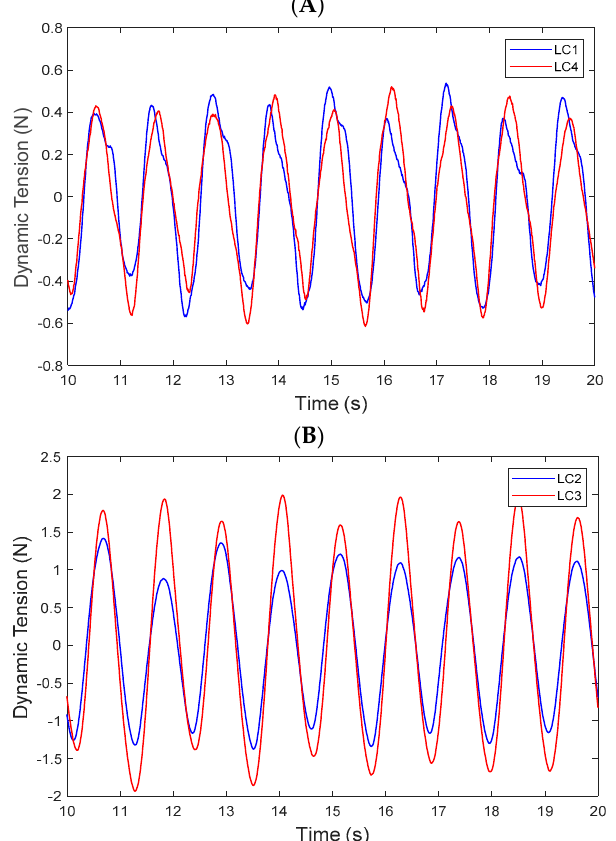
Figure 12. Time history of dynamic tendon tension measured by load cells for condition 3: LC1 and LC4 ( A ) and LC2 and LC3 ( B ).